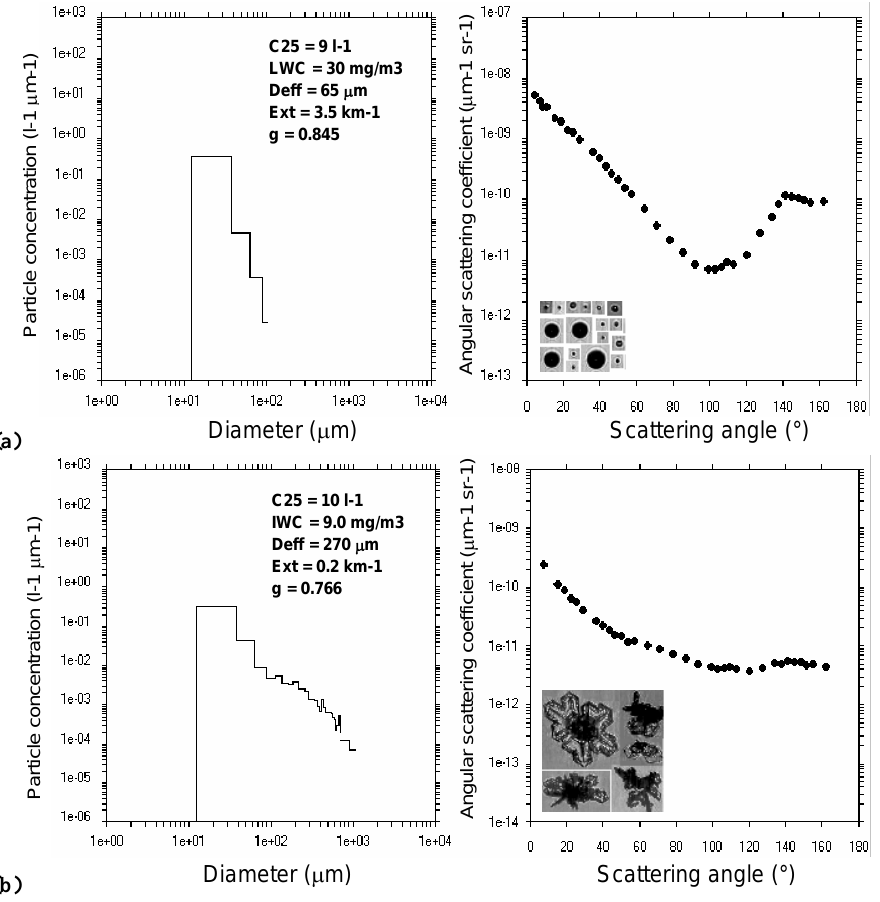
Fig. 4. (a) Example of measurements obtained between 10:30 and 10:31:30: Drizzle area. Left panel: PMS 2D-C size distribution and values of the corresponding parameters. Right panel: Measured scattering phase function by the Polar Nephelometer. (b) Same as panel (a). Example of measurements obtained between 10:35 and 10:42: Ice particles